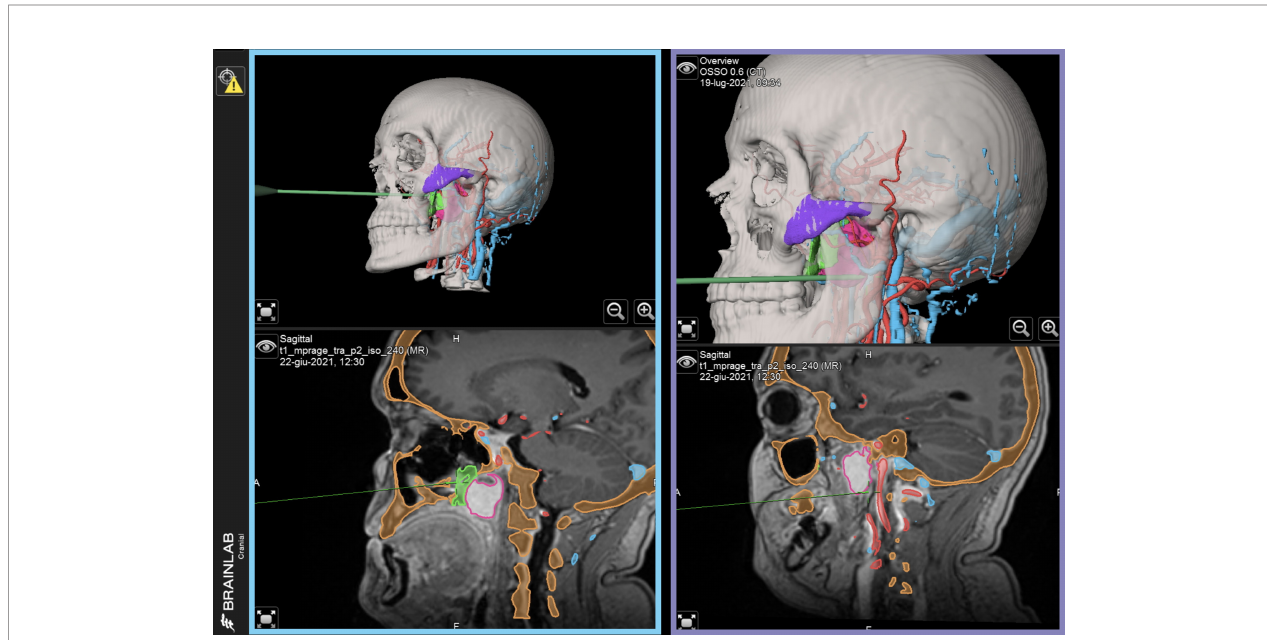
FIGURE 5 | Intraoperatively navigated sequences. STL fi les of virtual surgical planning are navigated during surgery, providing reference for each phase. Left, blue panel: navigation of transnasal endoscopy. Right, purple panel: navigation of transoral